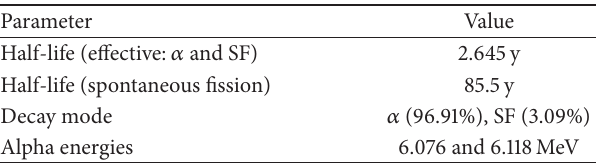
Table 2: 252 Cf decay